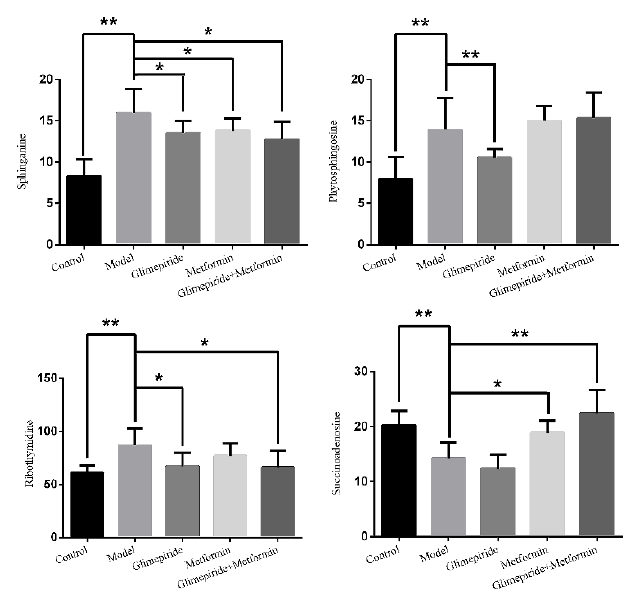
Figure 5. The endogenous metabolites that changed after treatment with glimepiride, metformin, and their combination. The values are shown as mean ± SD for six animals. * p < 0.05 versus values for the model group; ** p < 0.01 versus values for the model group.